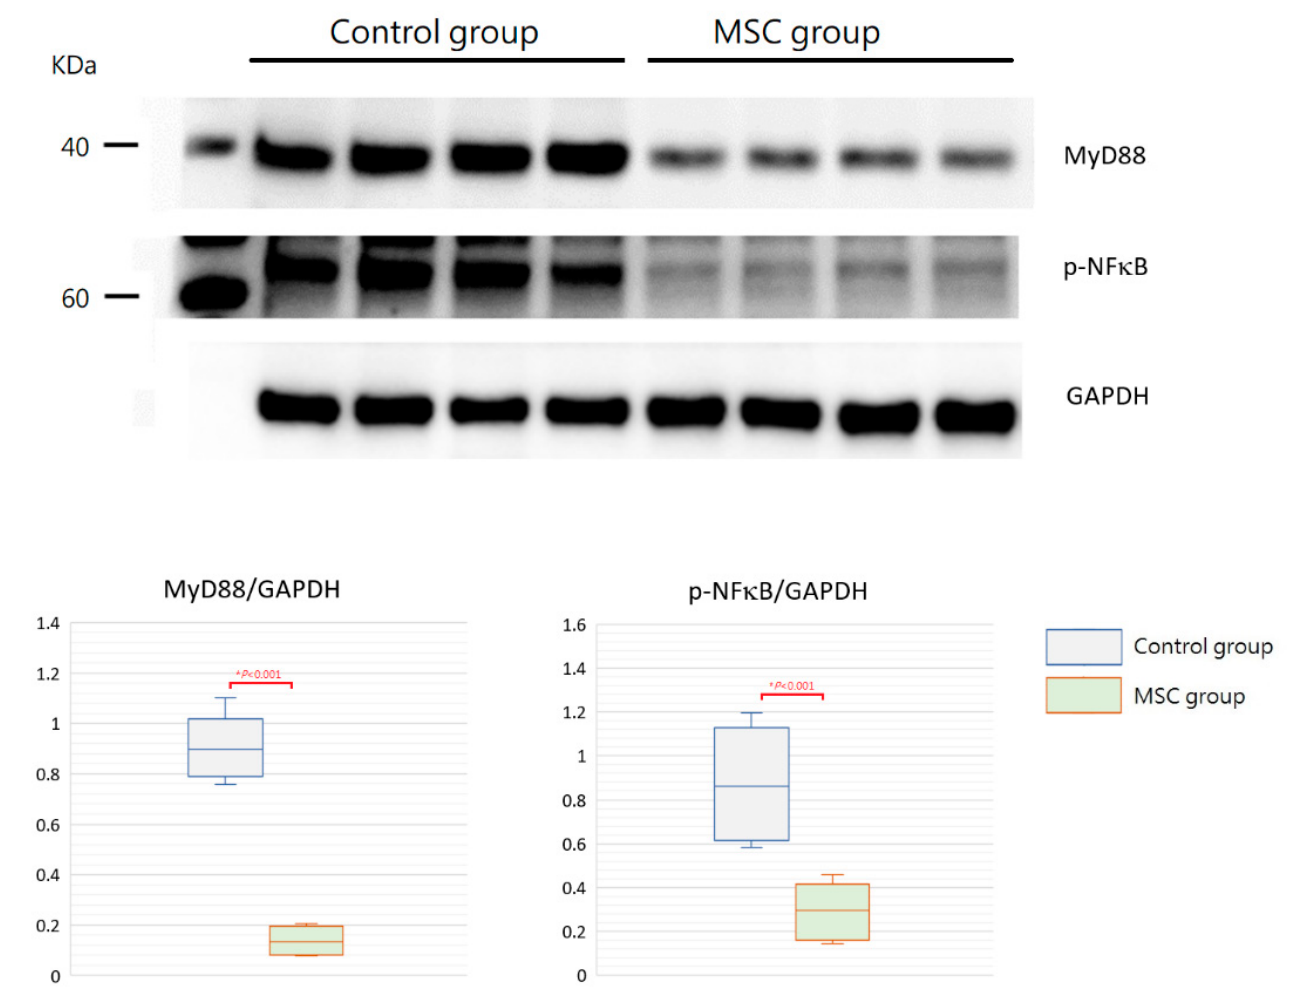
Figure 7. Western blot analysis for MyD88 and phospho-NF κ B in the lung tissue at 48 h after LPS-induced ALI. As shown with boxplots, expressions of MyD88 and phospho-NF κ B were decreased significantly in the MSC group. GAPDH was used as the loading control. n = 4 mice/group.